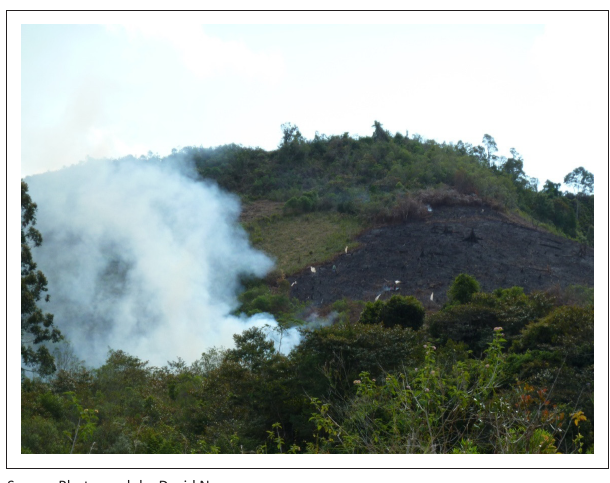
FIGURE 5: Slash and burn agriculture in the vicinity of Andasibe National